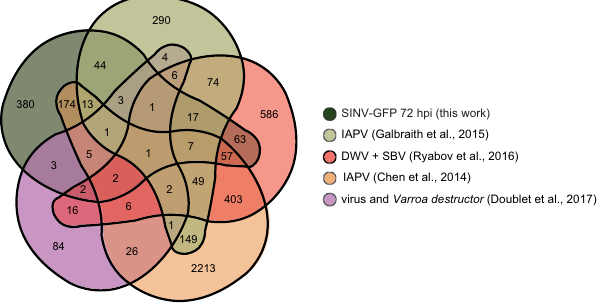
Figure 6. Venn diagram of shared and unique DEGs in bees infected with viruses from this and other studies. The DEGs identified in SINV-GFP-infected bees 72 hpi were compared to those identified in naturally IAPV- infected bees (Chen et al . 2014, orange) 9 , bees infected with IAPV via oral inoculation (Galbraith et al ., 2015, green) 24 , SBV and DWV-infected bees (Ryabov et al ., 2016, pink) 25 , and a common DEG list that was compiled from 19 gene expression data sets including Varroa destructor -parasitized and virus-infected bees (Doublet et al ., 2017) 92 (purple). Lists of DEGs from all studies that were used to generate the Venn diagram 131 are provided in Supplementary Tables S14 and Venn diagram results are listed in